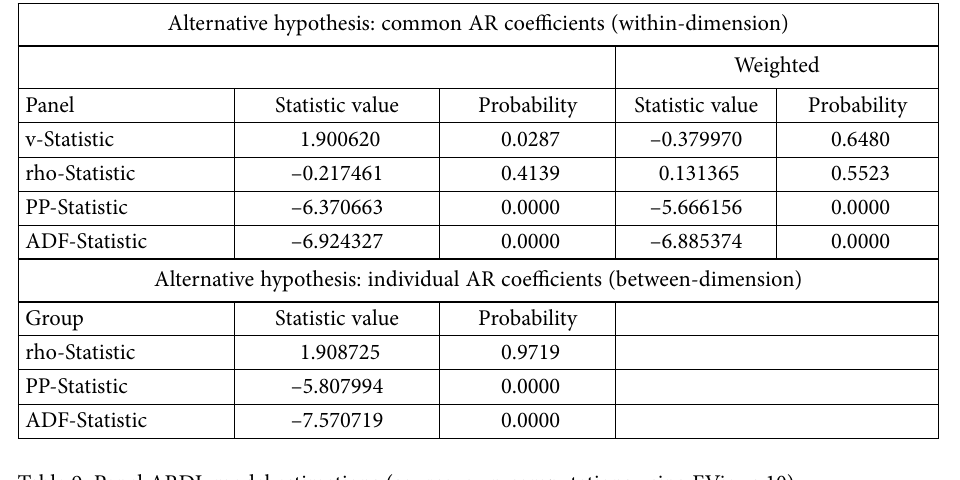
Table 8. Data cointegration analysis (source: own computations using EViews 10)